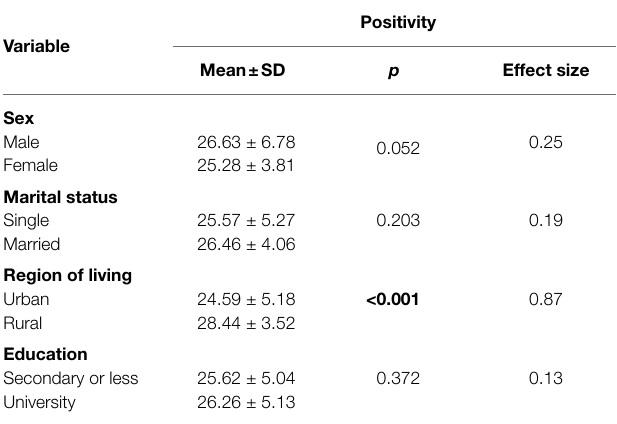
TABLE 2 | Bivariate analysis of the categorical variables associated with positivity.